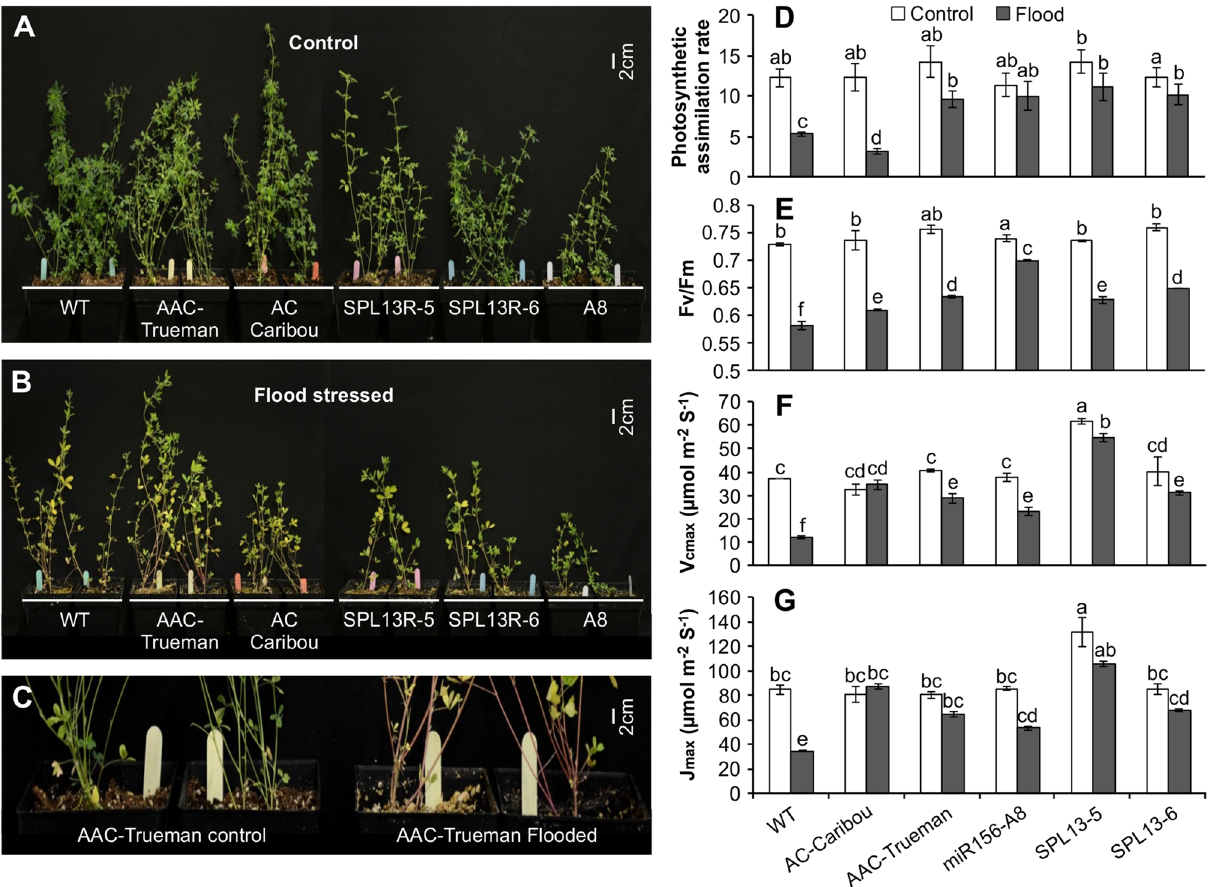
Figure 1. Physiological responses of flood-stressed and control plants. One-month alfalfa plants growing under ( A ) control, and ( B ) flood-stressed conditions, ( C ) stem colour development in AAC-Trueman plants upon flood stress, ( D ) photosynthesis assimilation rate in µ mol CO 2 m −2 leaf area S −1 , ( E ) chlorophyll fluorescence response, Fv/Fm, ( F ) V cma x , the maximum rate of rubisco carboxylase activity, ( G ) J max , maximum photosynthesis electron transport rate. Values are sample means ± SE, n = 8 individual plants. A significant difference from ANOVA was followed by Post hoc Tukey multiple comparisons test and indicated with different were suggested to correlate with reduced cytokinin levels 45 , a correlation observed in all alfalfa genotypes in this study (Fig. 2I). The detailed hormone profile is provided in Table S6.